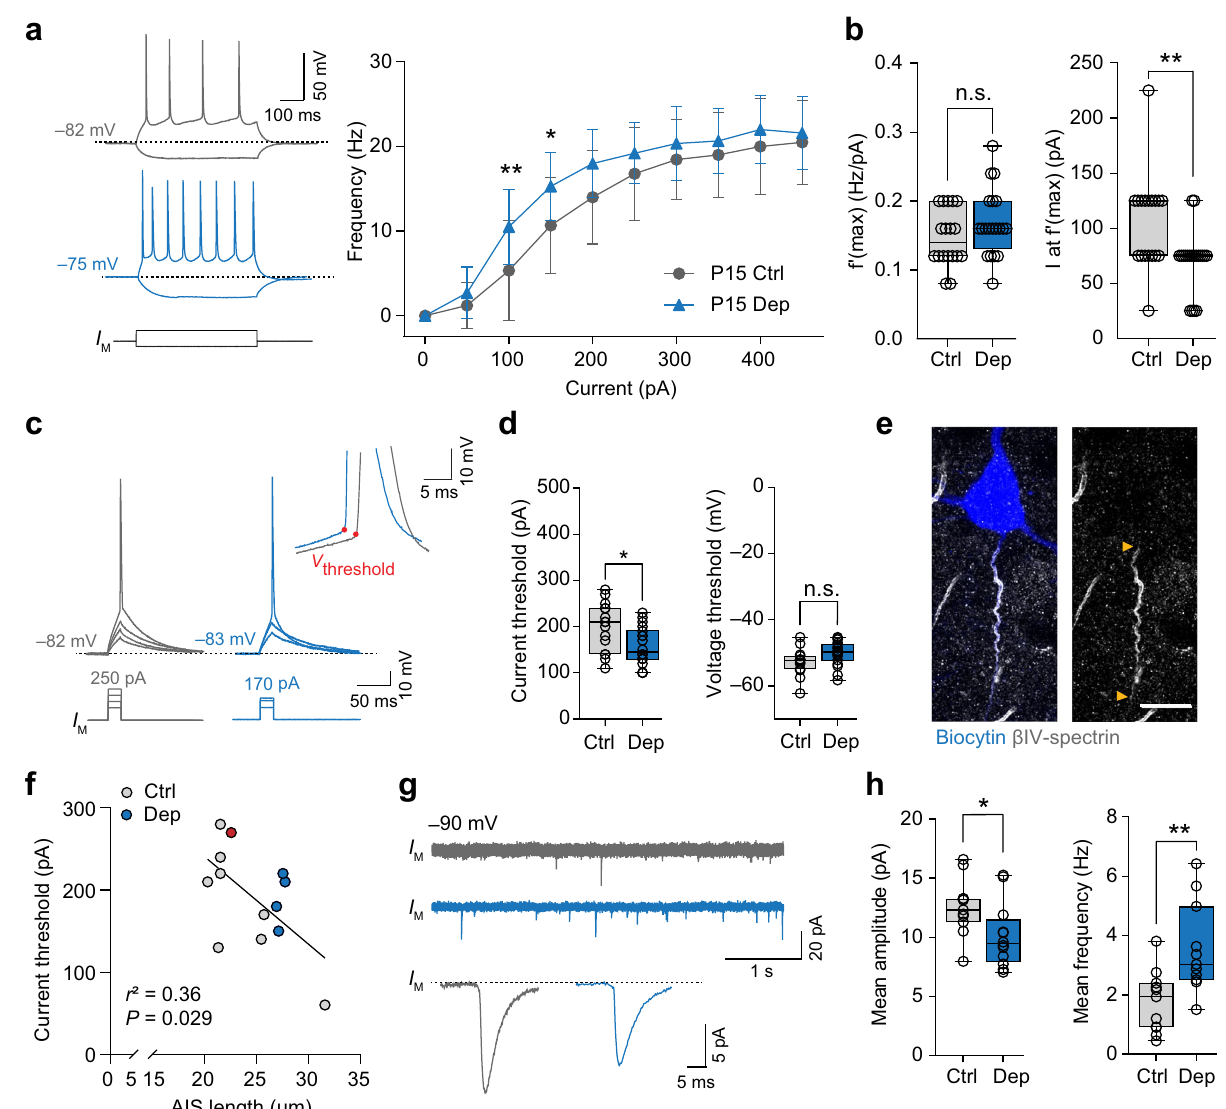
Fig. 3 Whisker trimming increases neuronal excitability in layer II/III pyramidal neurons. a Left: Representative traces of AP trains elicited by current injection (500 ms, – 50 pA, + 100 pA). Note the increased fi ring frequency in the deprived neurons (blue trace). Right: Input/frequency relationship as determined by 500 ms injections of increasing currents. The deprivation group showed signi fi cantly increased fi ring frequencies (Two-way ANOVA *** P < 0.0001 for current injection and deprivation, Holm – Sidak ’ s multiple comparison test * P = 0.014, ** P = 0.0037, n = 15 Ctrl cells, 20 Dep cells from at least 6 biologically independent experiments). Data are presented as mean ± SD. b Analysis of maximum slope f ’ (max) of the I - f curve and current at the maximum slope I at f ’ (max). Current at f ’ (max) was signi fi cantly lower in the deprivation group (Mann – Whitney test ** P = 0.0028). Maximum slope was unchanged (unpaired two-sided t -test P = 0.15; n = 14 Ctrl cells, 18 Dep cells from at least 6 biologically independent experiments). c Representative traces of single APs elicited by 20 ms current injections; 10 pA increment injections to determine current and voltage threshold (inset). d Deprived neurons had signi fi cantly lower current threshold; voltage threshold was unchanged (unpaired two-sided t -test, current threshold * P = 0.015, voltage threshold P = 0.070 n = 15 Ctrl cells, 18 Dep cells from at least 6 biologically independent experiments). e Representative confocal image of a P15 Dep neuron fi lled with biocytin (blue) for post-hoc determination of AIS length ( β IV-spectrin, gray). Arrowheads indicate start and end of AIS. Scale bar 10 µ m. f Correlation analysis of the relationship between AIS length and current threshold. Results of linear regression analysis indicated in fi gure ( n = 13 cells from at least 6 biologically independent experiments). Red dot indicates sample cell from image in e . g Left: Representative traces of spontaneous postsynaptic currents (PSCs) recorded at – 90 mV. Top trace: 6 s of recording. Bottom trace: averaged PSCs across the entire recording session of 2 min for two sample cells. Right: Mean amplitude and frequency of PSCs. Deprived neurons received signi fi cantly more input, with on average a lower amplitude (unpaired two-sided t -test, amplitude: * P = 0.035, frequency: **P = 0.0042, n = 11 cells for Ctrl and Dep from at least 6 biologically independent experiments). Boxplots: median with 25 – 75% interval, error bars show minimum to maximum